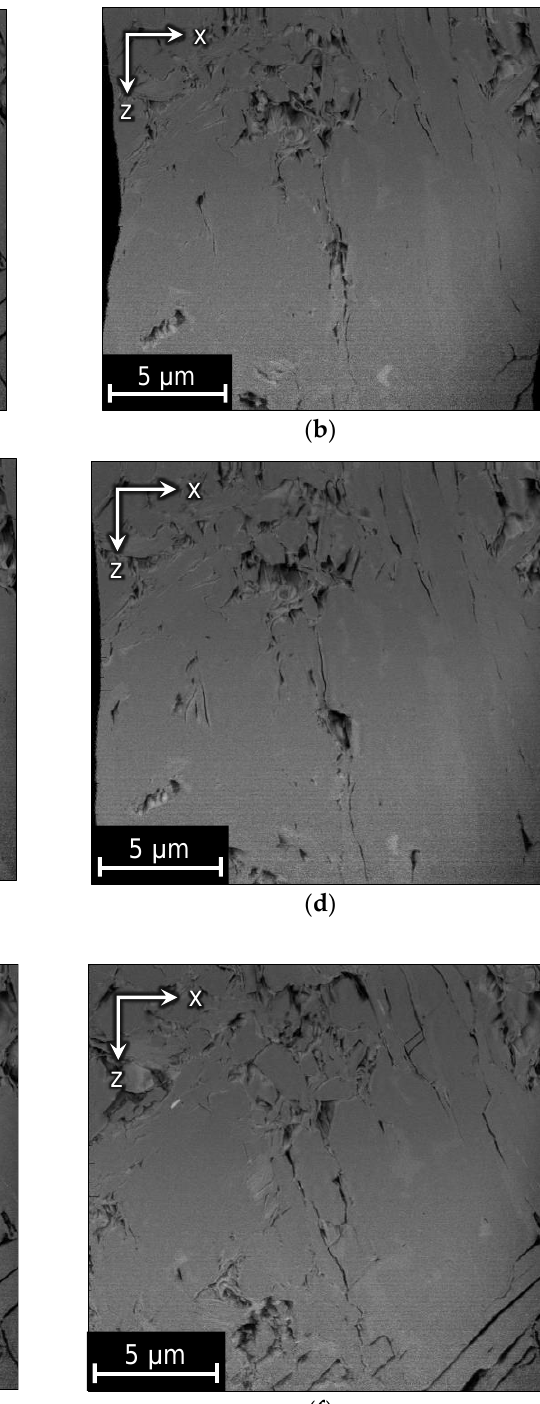
Figure 18. The side view of the image B: ( a ) GT; ( b ) aligned with SAD; ( c ) aligned with StackReg; ( d ) aligned with JavaSIFT; ( e ) aligned with Elastic; ( f ) aligned with the proposed algorithm. Alignment metrics are presented in Table 4. Alignment metrics for image B. Again, the proposed approach has better values than other